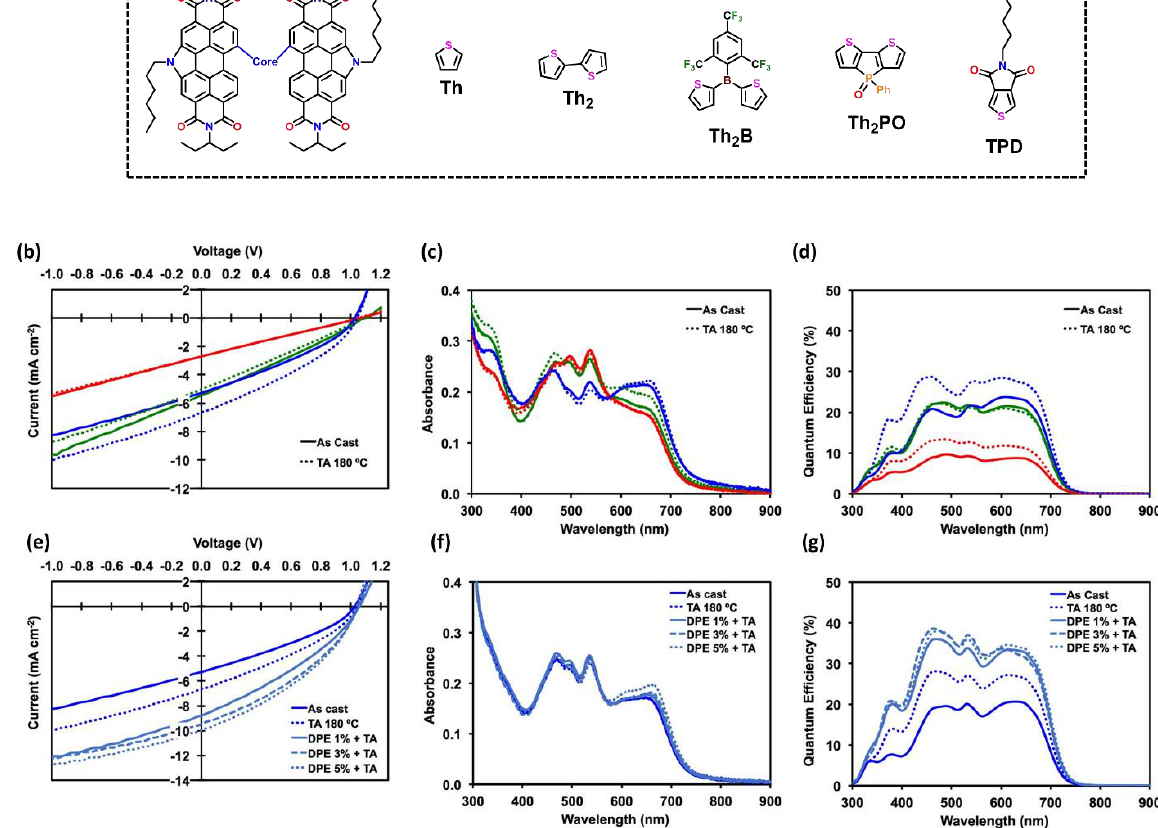
Figure 8. ( a ) Chemical structure of the PDI-Core-PDI framework and various thiophene core linkers, ( b ) device J – V curves, ( c ) UV–Vis absorption spectra, and ( d ) device EQE for best devices with as-cast and thermally annealed TTFQx-T1/acceptor active layers (green = TTFQx-T1/PDI-Th 2 -PDI; red = TTFQx-T1/PDI-Th 2 PO-PDI; blue = TTFQx-T1/PDI-Th 2 B-PDI). ( e ) device J – V curves, ( f ) UV–Vis absorption spectra, and ( g ) device EQE for best devices with as-cast, thermally annealed, and DPE additive processed TTFQx-T1/PDI-Th 2 B-PDI active layers [92]. ( b – g ) reproduced with permission from [92]. Copyright 2019 American Chemical Society.